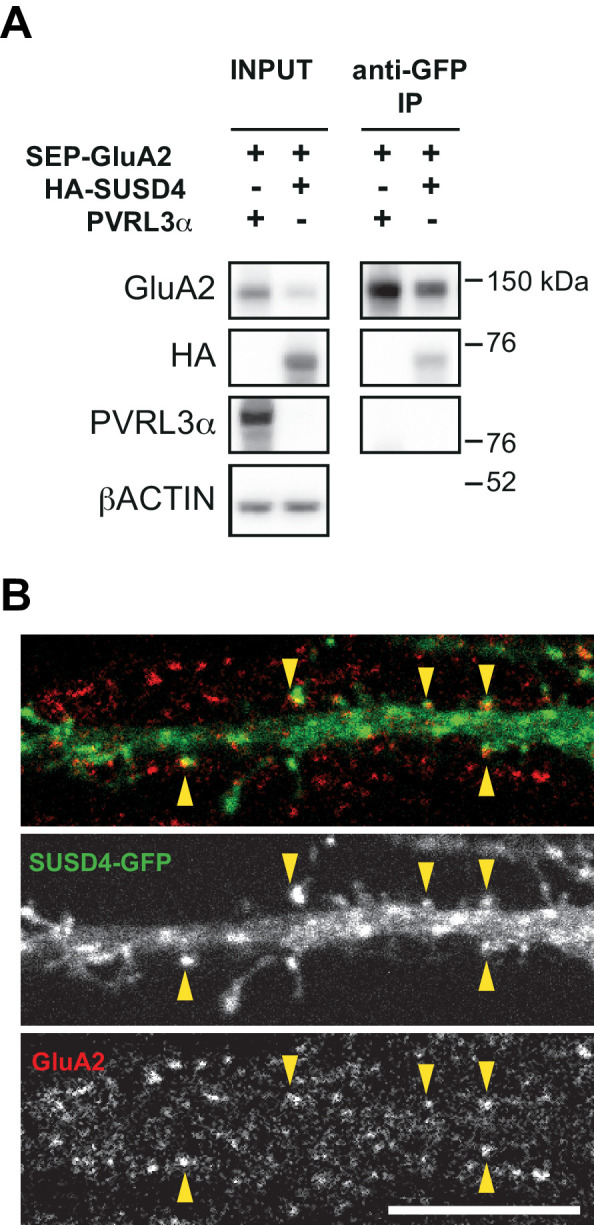
Interaction and colocalization of HA-SUSD4 and the AMPA receptor subunit GluA2.(A) SUSD4 interaction with GluA2 was assessed by co-immunoprecipitation using HEK293 cells transfected with SEP-GluA2 together with PVRL3α as a control or HA-SUSD4. Affinity purification was performed with an anti-GFP antibody and extracts were probed for co-immunoprecipitation of GluA2 (with an anti-GluA2 antibody) and of HA-SUSD4 (anti-HA antibody) or PVRL3α (anti-PVRL3α antibody). βACTIN was used as a loading control. Representative of N = 3 independent experiments. (B) Mouse hippocampal neurons were transfected at 13 days in vitro (DIV13) with a GFP-tagged SUSD4 construct and immunostained at DIV17 for green fluorescent protein (GFP, green) to localize SUSD4 and for the endogenous GluA2 subunit (anti-GluA2, red). The arrowheads indicate the spines containing SUSD4 and GluA2. Scale bar 10 μm.